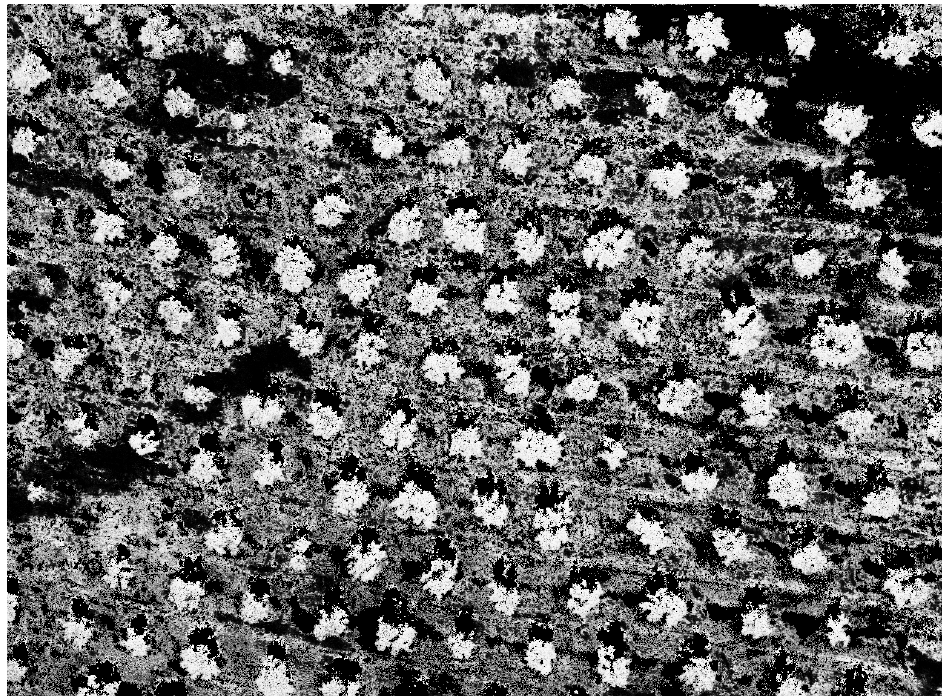
Figure 5. Probability image associated with capture 0. It is a greyscale image in which the values of each pixel indicate the probability of belonging to the olive tree class. This probability is calculated by a decision tree that receives as input only the pixels classified as vegetation during